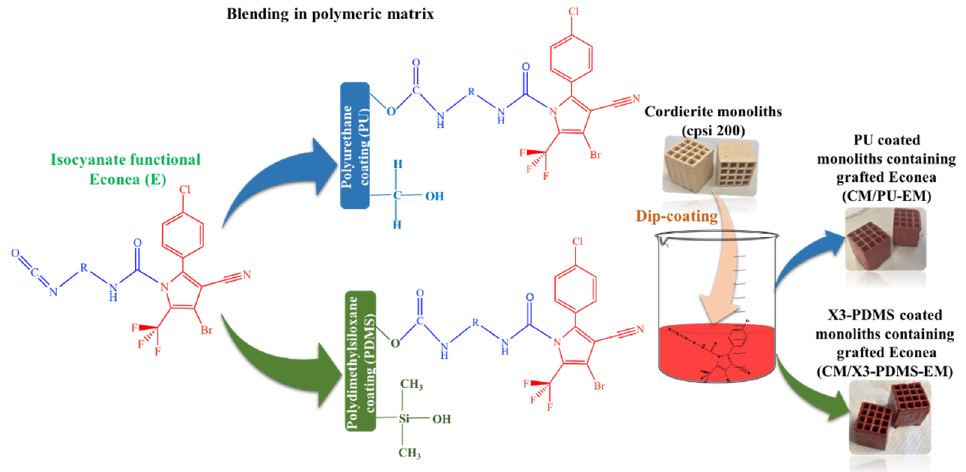
Figure 1. Eco-friendly strategy comprising the development of isocyanate-reactive biocides and their subsequent grafting in different representative polymeric matrices, polyurethane (PU)-based, and polydimethylsiloxane (X3-PDMS)-based paints to originate non-release antifouling coatings used to coat cordierite monolithic filters.